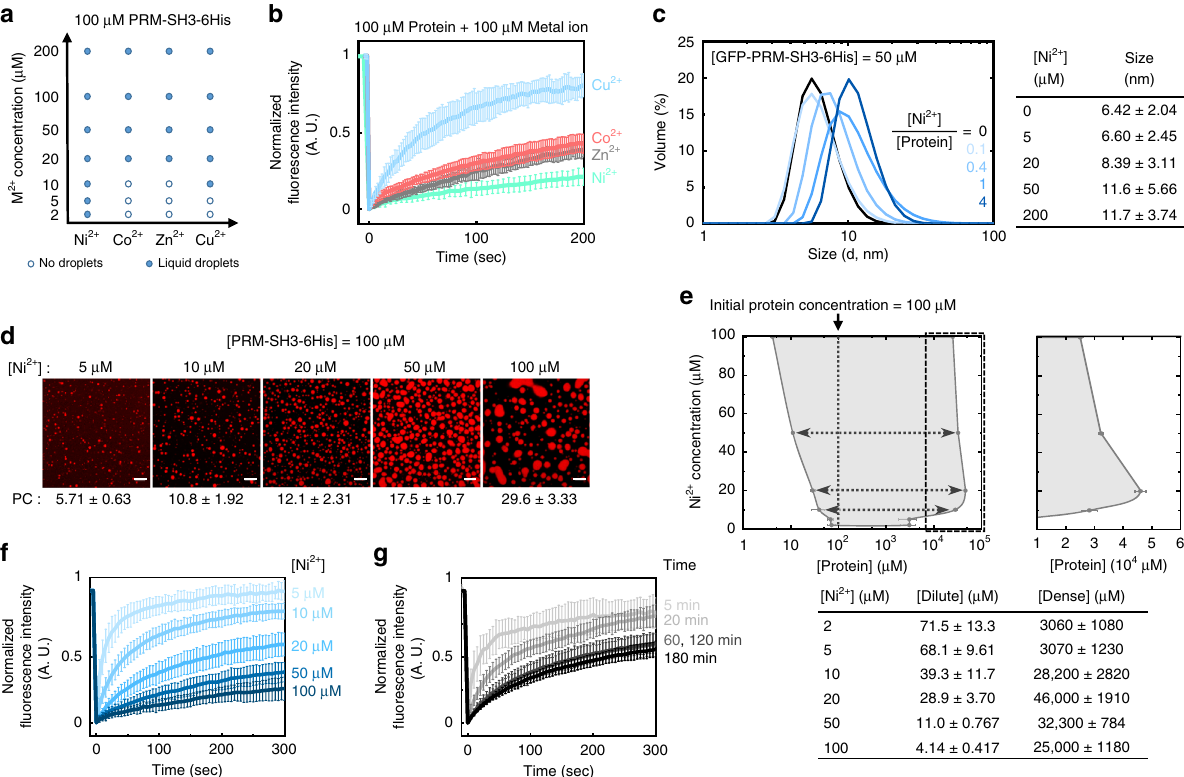
Fig. 2 Metal ion-dependent variation of protein phase separation. a A phase separation diagram of PRM-SH3-6His as a function of metal ion concentrations for four different metal ions. b FRAP recovery pro fi les of PRM-SH3-6His inside condensates with different metal ions. c DLS size distribution pro fi les of GFP-PRM-SH3-6His with varying ratios of Ni 2 + . Average sizes for different Ni 2 + concentrations are indicated in the right table. s.d. from n = 3. d Fluorescence images of PRM-SH3-6His condensates with varying Ni 2 + concentrations (analysis after 1 h upon metal addition). Scaffold PC values are indicated below. Scale bars: 10 μ m. e The phase diagram of PRM-SH3-6His with dense and dilute phase protein concentrations (analysis after 24 h upon metal addition). The left arm exhibits dilute phase concentrations, and the right arm for dense phase concentrations. The magni fi ed version of the right arm (dash box in the left diagram) is drawn (right diagram). Protein concentrations were listed in a below table. Error bars: 1 s.d. ( n = 3). f FRAP recovery pro fi les of PRM-SH3-6His inside condensates with different Ni 2 + concentrations. g FRAP recovery pro fi les of PRM-SH3-6His inside condensates with different incubation time. All FRAP analyses were conducted after 1 h upon metal addition. Error bars: 1 s.d. ( n =